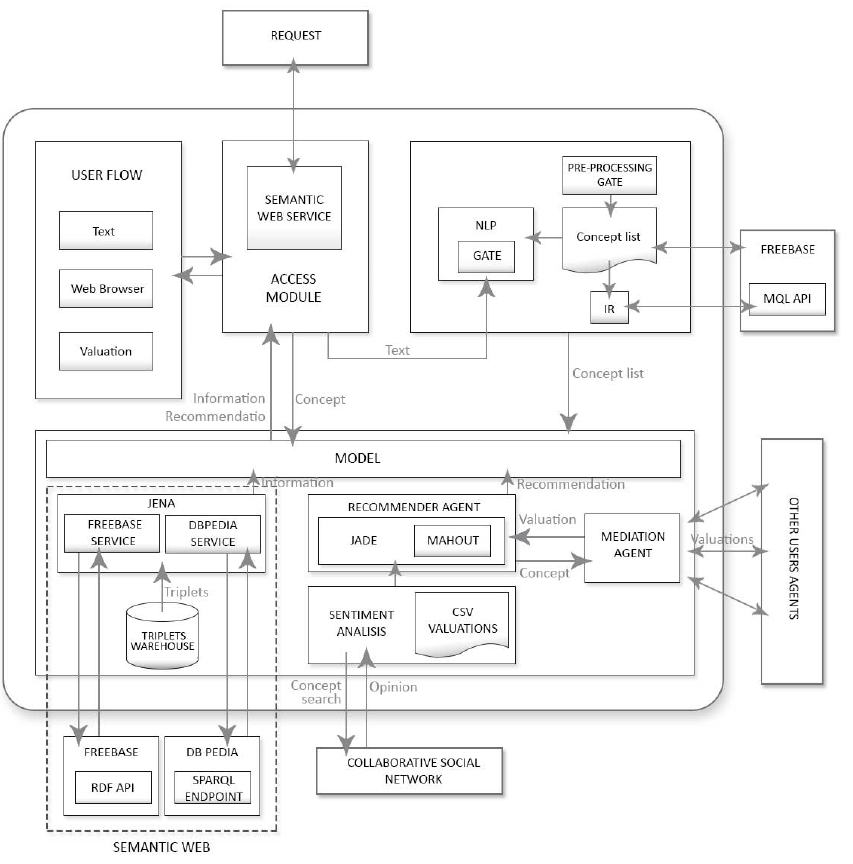
Figure 1. General architecture of the platform.